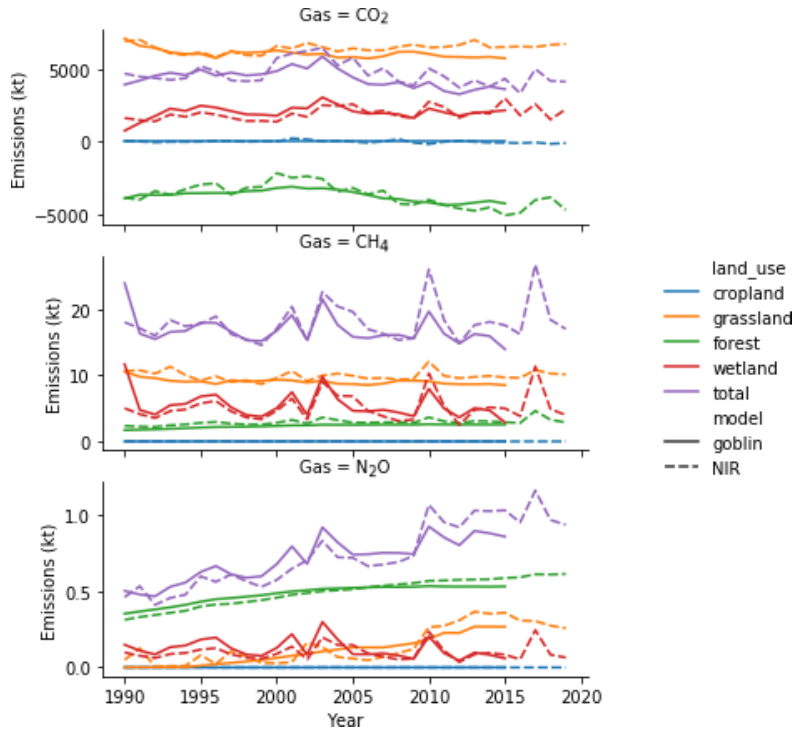
Figure 7. Comparison of land use GHG fluxes computed by GOBLIN with those reported in national inventory reports and derived from the same activity data for 1990 to 2015.